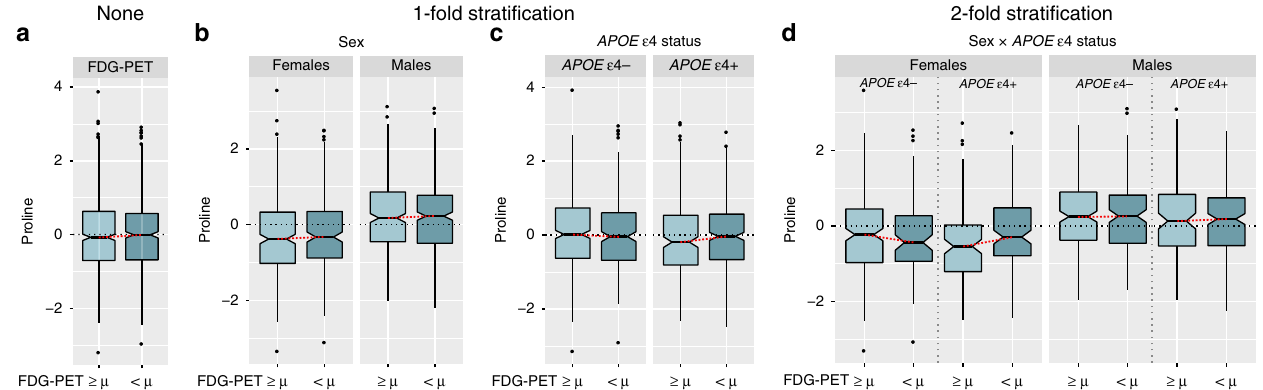
Fig. 2 Group-speci fi c association of proline levels with brain glucose uptake in APOE ε 4-carrying females. Boxplots showing residuals of proline levels (derived by regressing out covariate effects) for a the full sample; b onefold strati fi cation by sex; c onefold strati fi cation by APOE ε 4 status; and d twofold strati fi cation by both sex and APOE ε 4 status; separately for high (light blue) and low (darker blue; derived by mean-split) FDG-PET values. The only subgroup showing a signi fi cant difference in proline levels are APOE ε 4 + females with substantially higher levels in participants with lower brain glucose uptake. This Bonferroni-signi fi cant subgroup-speci fi c effect ( P = 8.2 × 10 − 5 in covariate-adjusted linear regression) would have been missed in sex/ APOE ε 4 genotype-adjusted analyses applying no or onefold strati fi cation. Source data are provided as Source Data